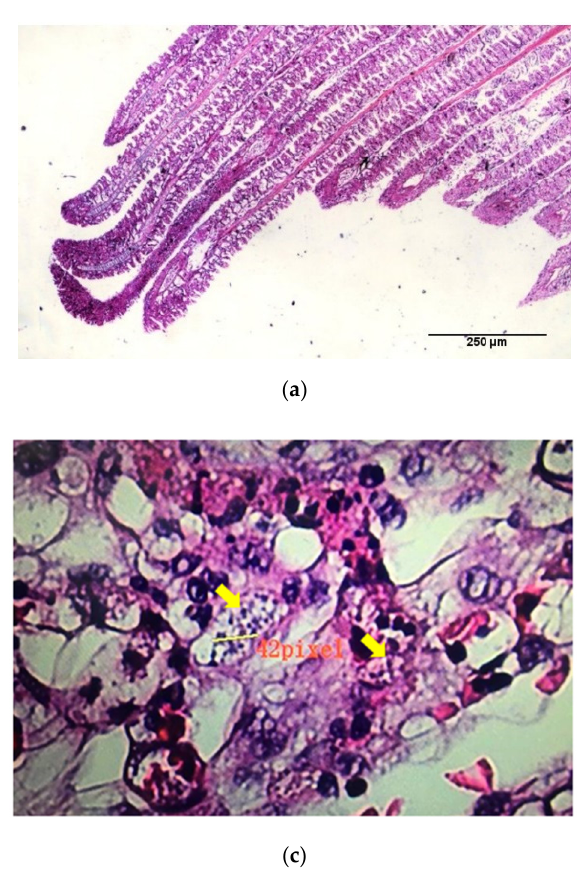
Figure 6. Histopathological sections of gill tissues of dead fish from the experimental challenge group. ( a , b ) The secondary gill lamella is infiltrated with inflammatory cells, showing the proliferation and fusion of the epithelial cells of the lamella (black arrows). ( c ) Typical coccobacilli can be seen inside the vacuoles (yellow arrows) (H&E Stain).